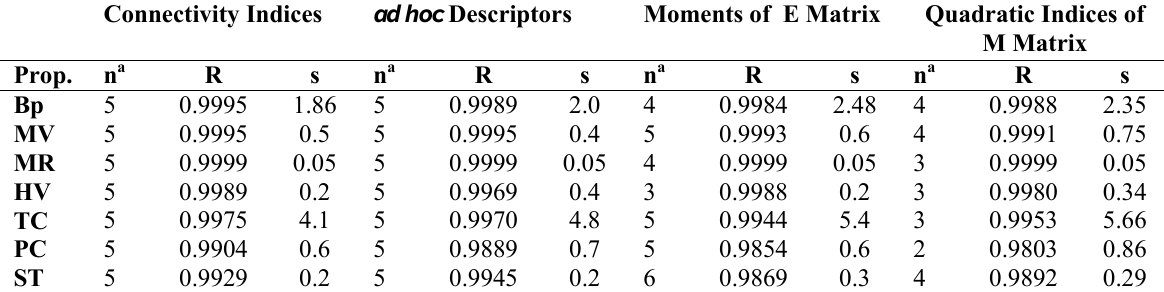
Table 6. Statistical Parameters for the Models Describing Physical Properties of Alkanes by Using Conectivity Indices, ad hoc Descriptors, Spectral Moments of Edge-Adjacency Matrix and Quadratic Indices of the Molecular Pseudograph(cid:146)s Atom.Adjacency